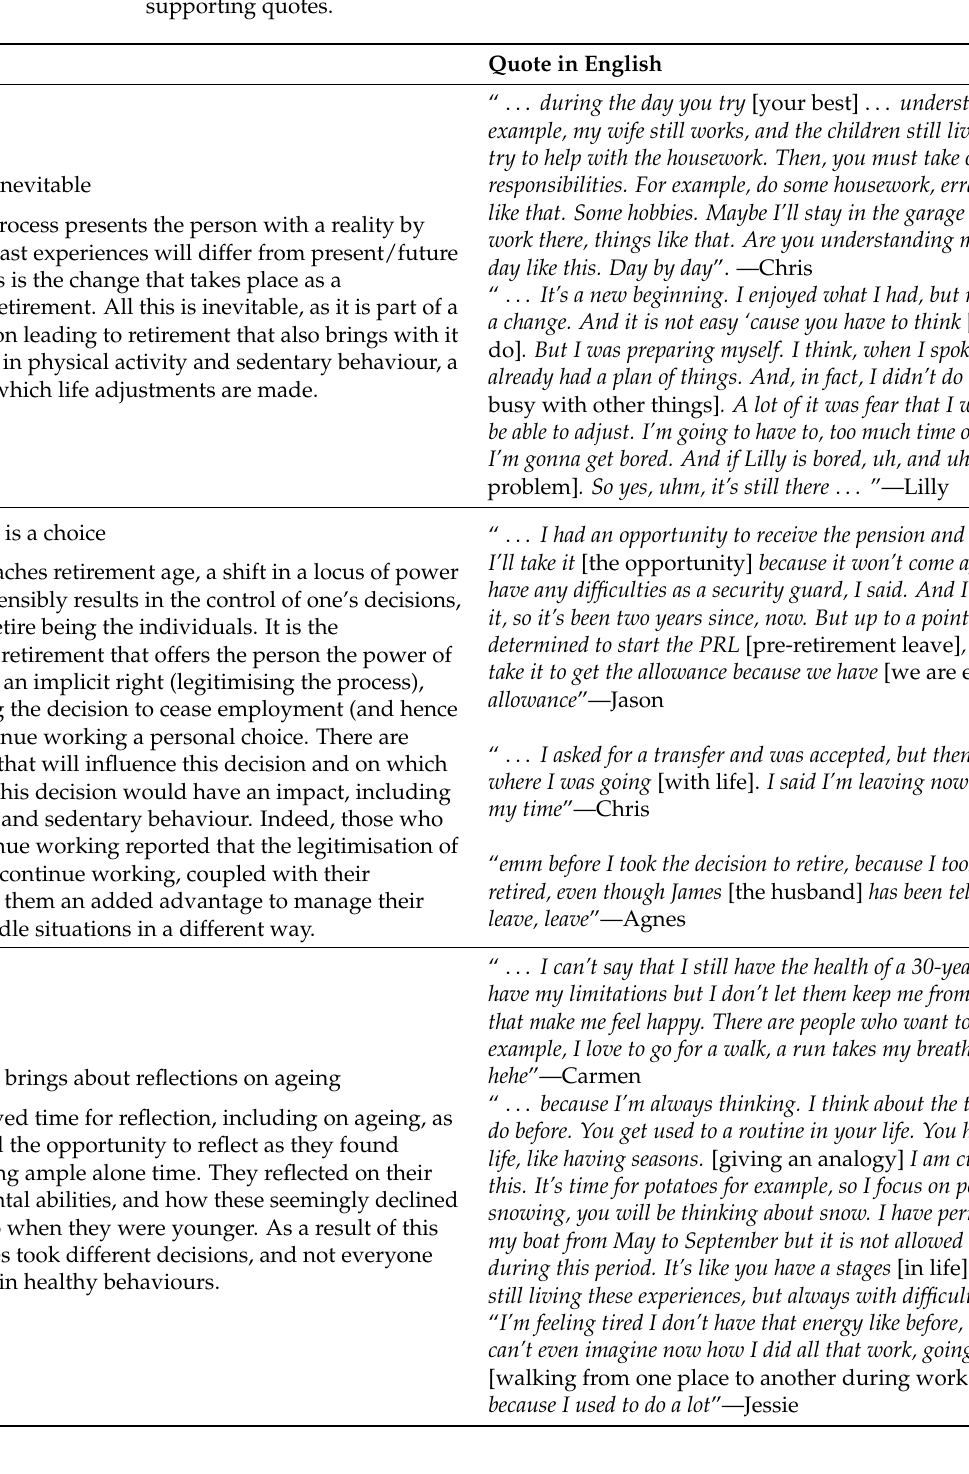
Table 4. Subthemes of theme one, ‘the impact of official retirement age is seemingly inexorable’, with supporting